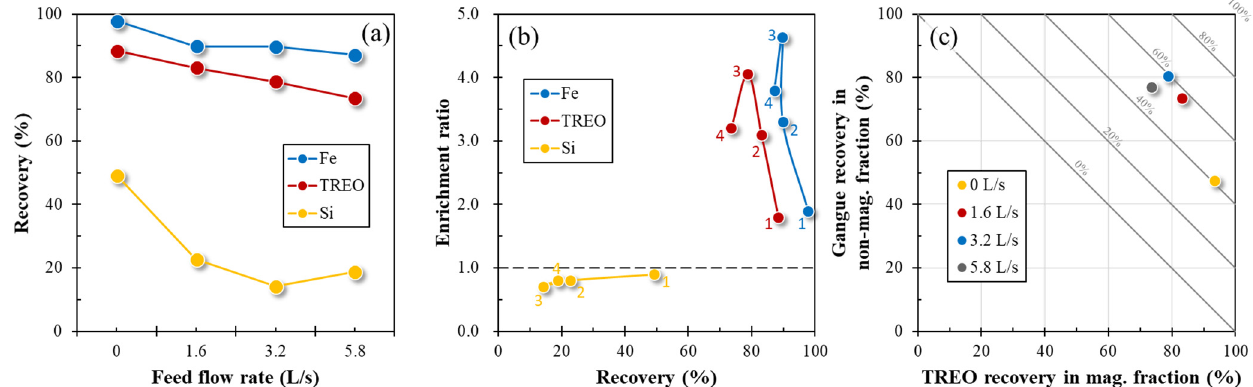
Figure 9. Effect of feed flow rate on ( a ) the recovery of TREO, Fe, and Si from REE ore, ( b ) enrichment ratio as a function of recovery, and ( c ) relationship between TREO recovery in magnetic fraction and gangue recovery in non-magnetic fraction. Note: The numbers in Figure 9b denote that the feed flow rate (1: 0 L/s, 2: 1.6 L/s, 3: 3.2 L/s, 4: 5.8 L/s).